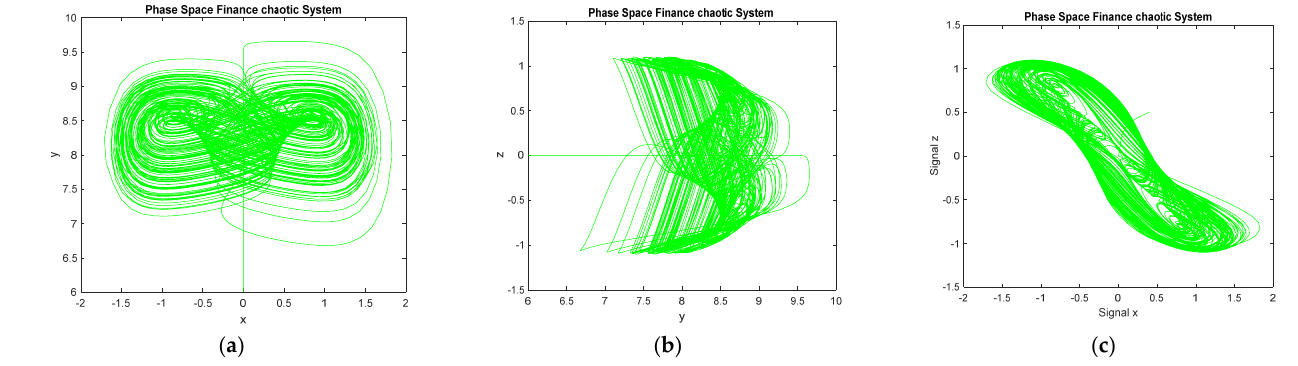
Figure 1. Output MATLAB simulation of the financial chaotic system (1) with Y (0) = (0.4, 0.2, 0.5) and ( a, b, c ) = (7.6, 0.1, 0.2): ( a ) x-y plane, ( b ) y-z plane, and (c) x-z plane.